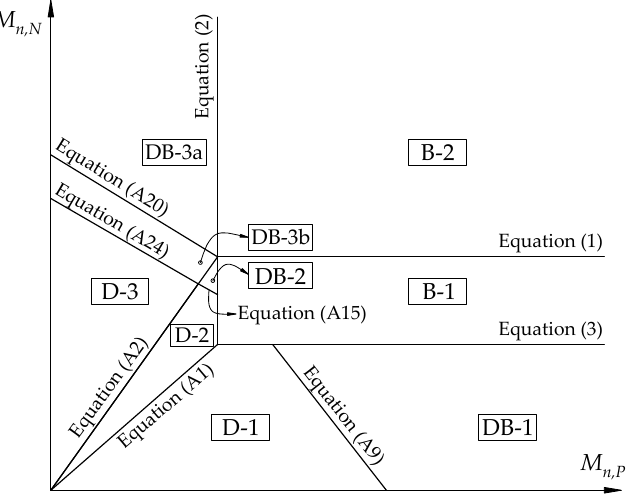
Figure 4. Different failure modes according to M n,P , M n,N , and V n for the end span of an RC slab.